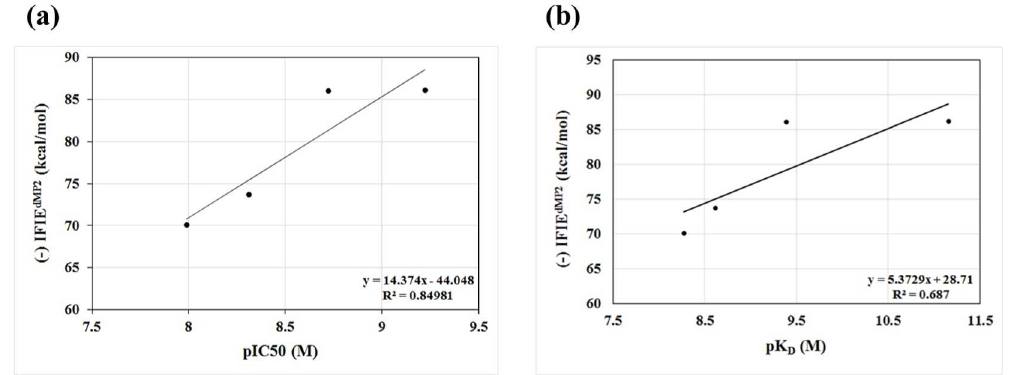
Fig 5. Relationship betweenhydrophobicIFIE (kcal/mol), calculatedbetweenthe inhibitorsand DPP-4, and (a) inhibitoractivity [pIC50] (valuestaken from Ref. 10 and 42) and (b) experimental bindingaffinity [pK D ] of the inhibitorsfrom surface plasmon resonance (SPR) data (values taken Ref. 12).